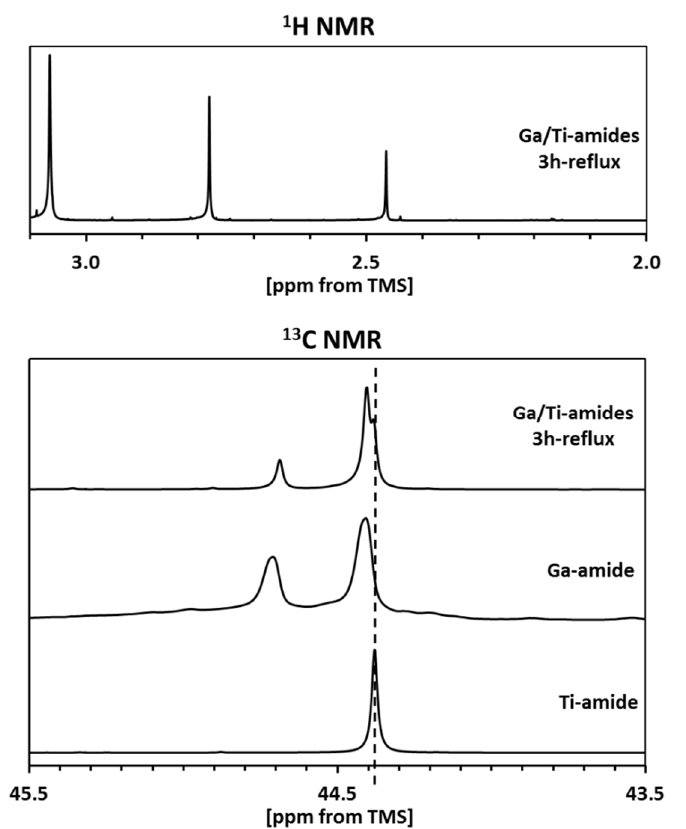
Figure 2. 1 H- (upper) and 13 C- (lower) NMR spectra in C 6 D 6 of bimetallic M-dimethylamide mixture (M = Ga, Ti; Ga/Ti = 1/1 at.) refluxed in hexane. 1 H-NMR spectrum is shown for bimetallic product only, whereas 13 C-NMR results also include spectra for individual/pure M-dimethylamides. The dashed line shows the position of 13 C-NMR resonance for monomeric Ti-dimethylamide and serves as a guide for the eye only.